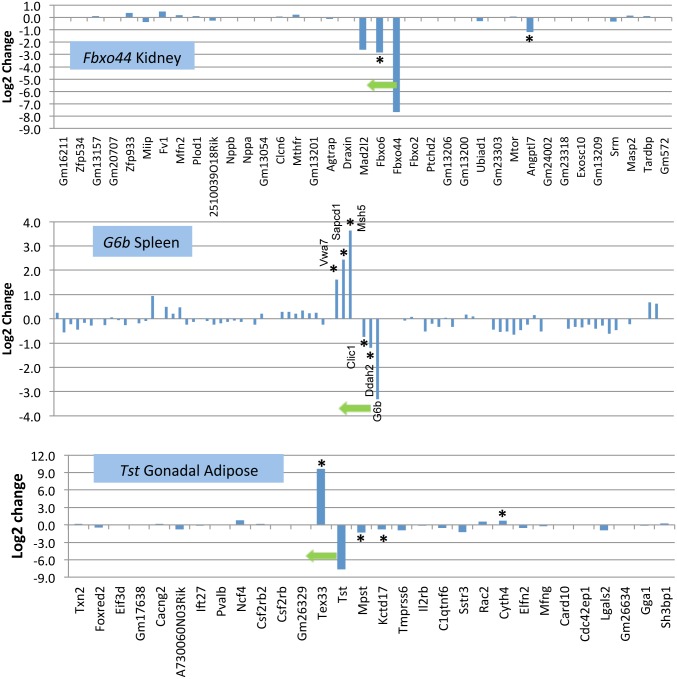
Regional effects of gene targeting in kidney of TRAP Fbxo44 mutant (Top Panel), in spleen of DEL G6b (AU023871) mutant (Middle Panel), and in gonadal adipose tissue of DEL Tst mutant (Bottom Panel).The genes listed on the X-axis are all found in S1 Table for each targeted gene. In HOM Fbxo44 kidney, flanking gene Fbxo6 is significantly down-regulated relative to WT controls. In HOM G6b lung, two flanking genes are down-regulated, while three genes 3’ to G6b are up-regulated. In HOM Tst adipose tissue, gene Tex33 3’ to Tst is highly up-regulated, while Mpst1 5’ and Kctd17 are down-regulated. Gene symbols are listed in centromere to telomere order from left to right without consideration of distance or spacing. The total interval depicted in each graph is +/- 500 kb flanking the centrum of the targeted gene. Asterisks indicate a significant dysregulation by the DESeq2 statistic. Arrow indicates direction of targeted gene transcription.